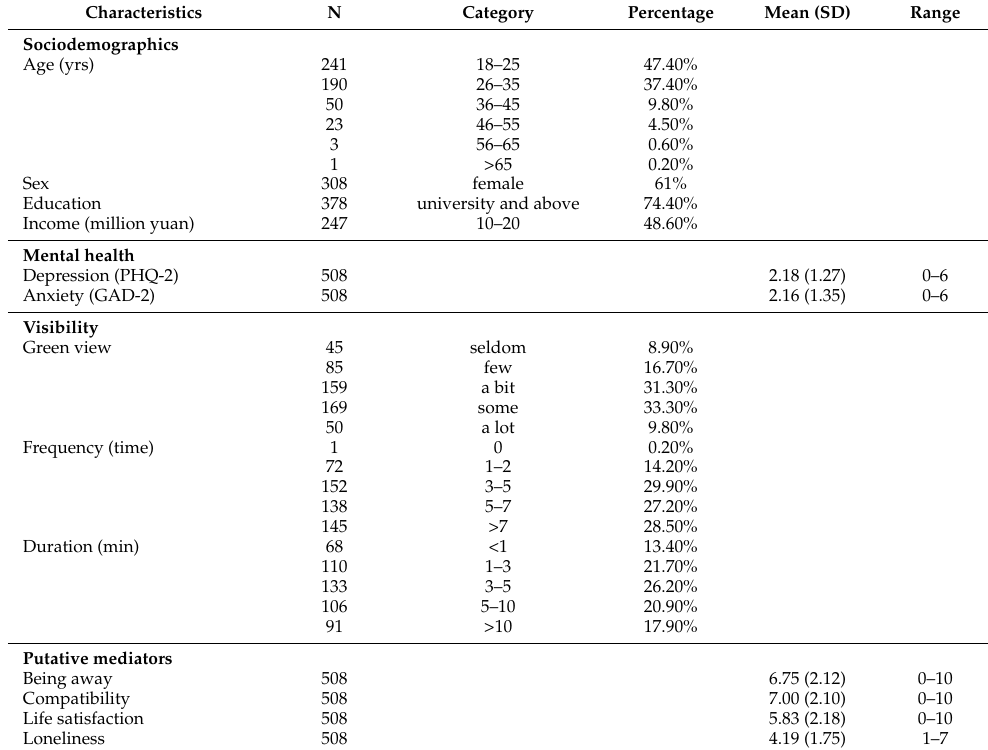
Table 2. Participant characteristics (N =